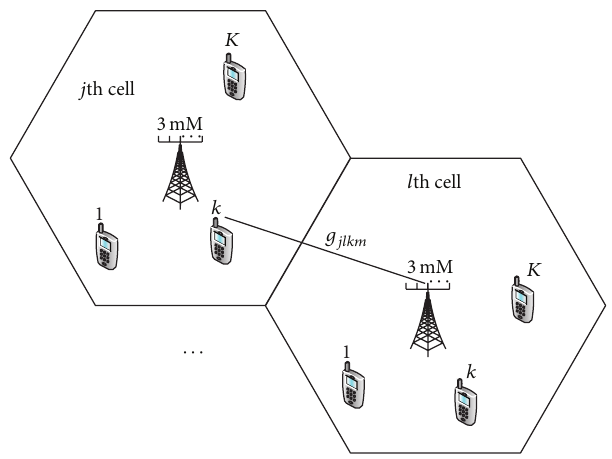
Figure 1: A multicell massive MIMO system